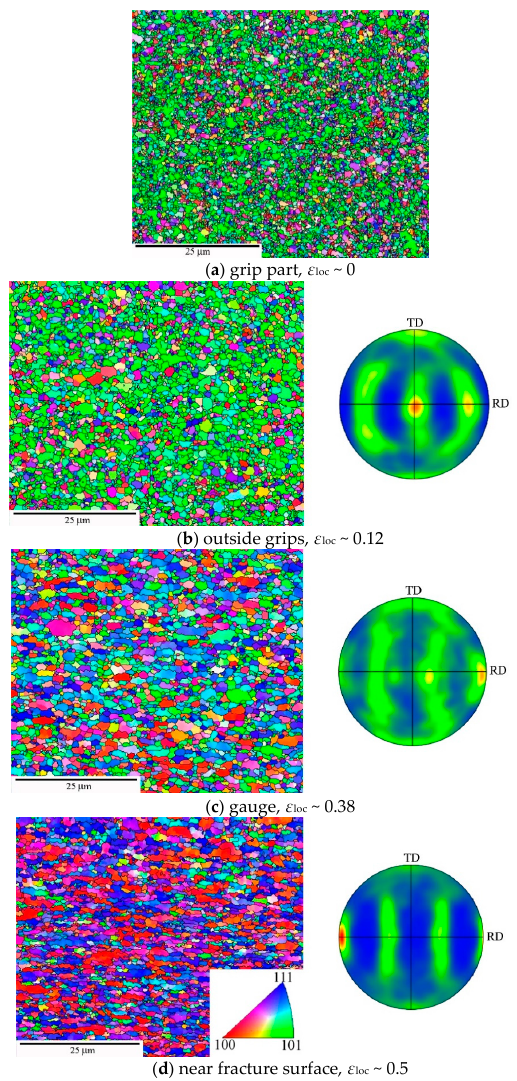
Figure 10. Grain structure and texture of HPS15 after creep at 160 MPa for ~7 h in grip and gauge with different ε loc . RD directions are parallel with the stress axis.